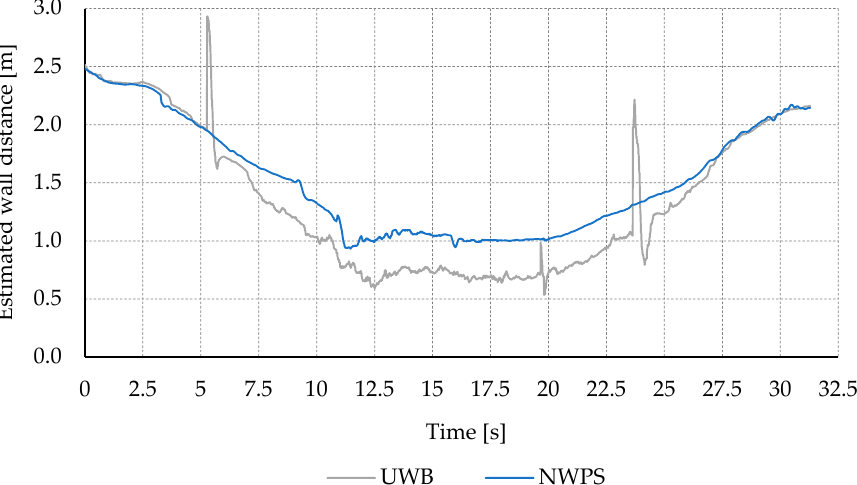
Figure 9. Estimation of the distance to the wall in an indoor flight test. Comparison between results from the UWB and the proposed NWPS.